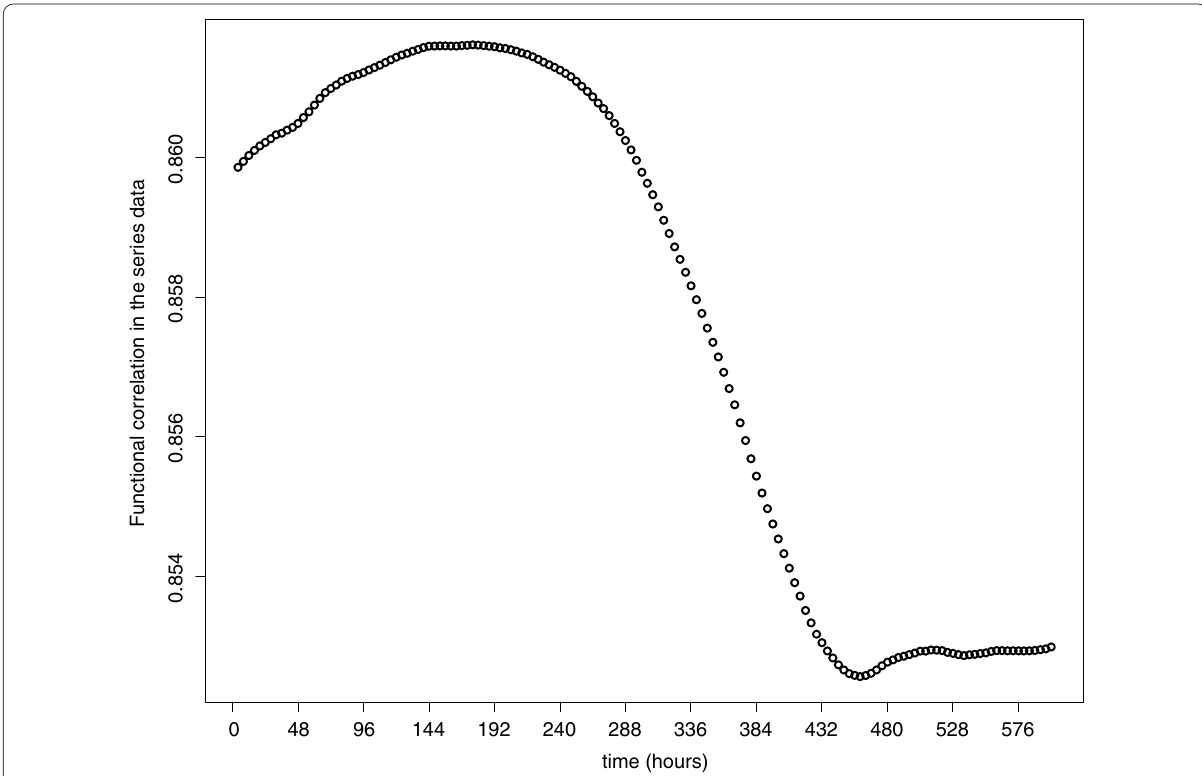
Fig. 8 Correlations in absolute value between the standardized cumulative energy released curve and the surface deformation curve, moving the last curve among 0 and 600 h. The absolute maximum correlation between the curves ( r = 0.86 ) appears when the curve about surface deformation is moved in 176 h, that in this problem it corresponds approximately to 7